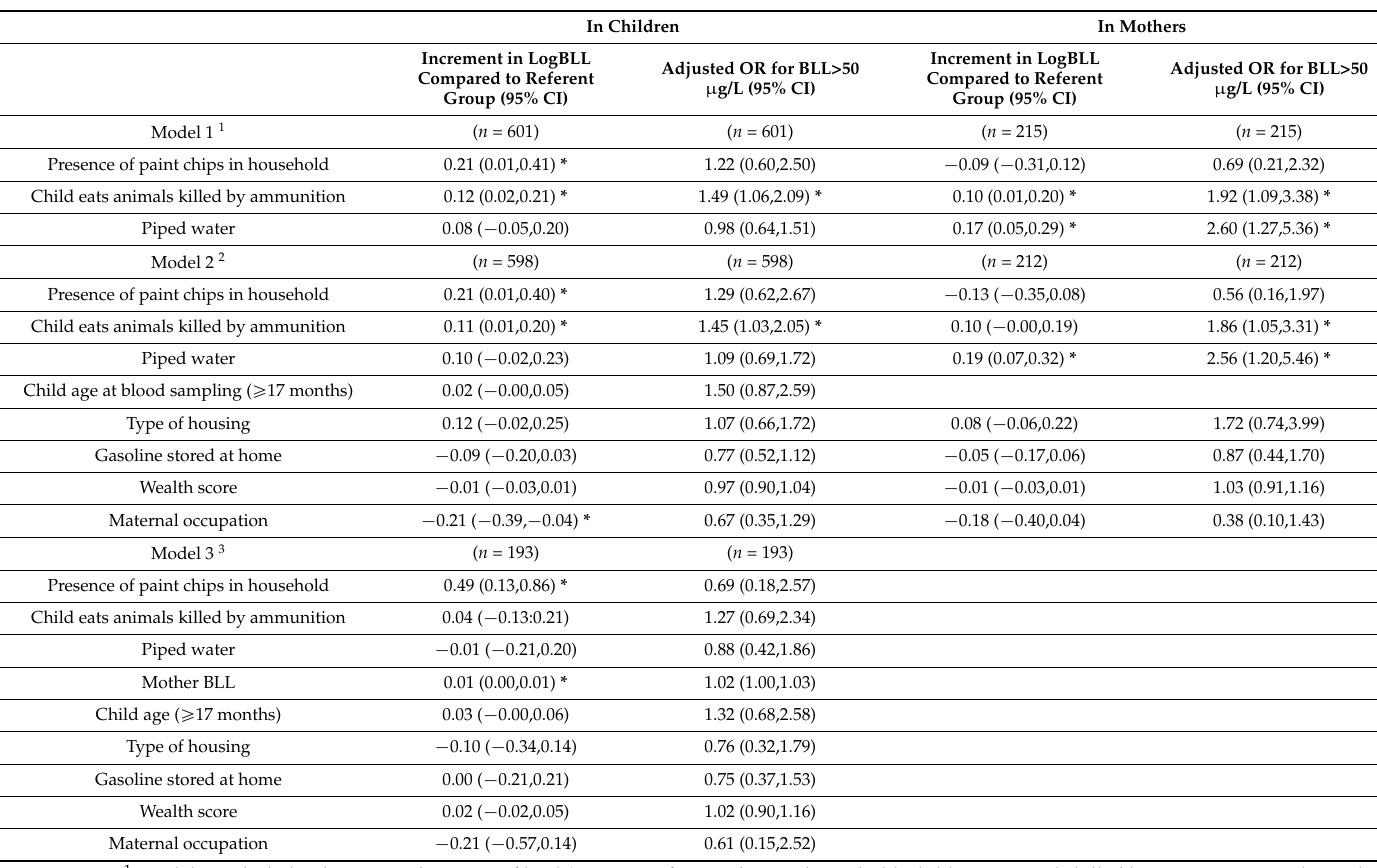
Table 3. Multivariate analysis of association between potential sources of lead and BLL after adjustment for other sources of lead, socioeconomic status and maternal